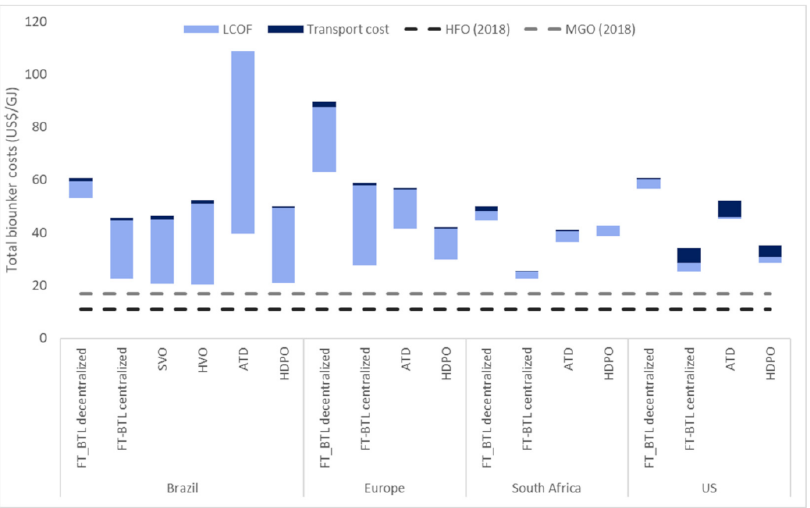
Figure 22. Total biobunker cost